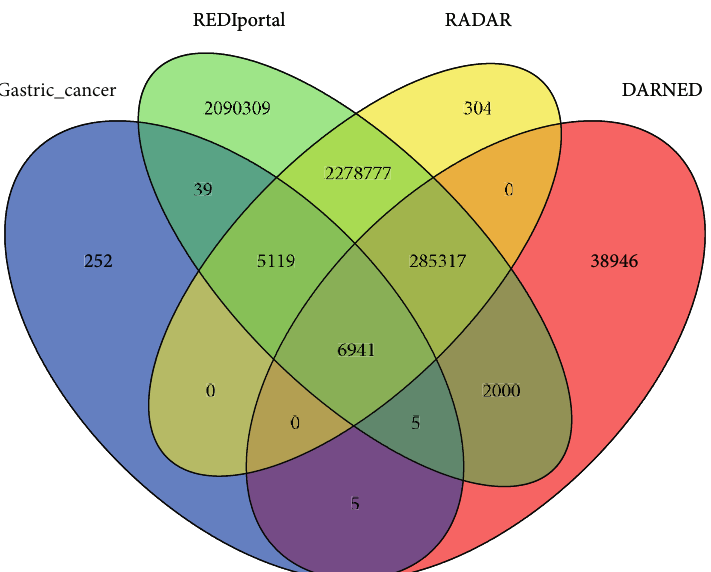
Figure 2: Venn diagram of identi fi ed editing sites in our study and three other databases.